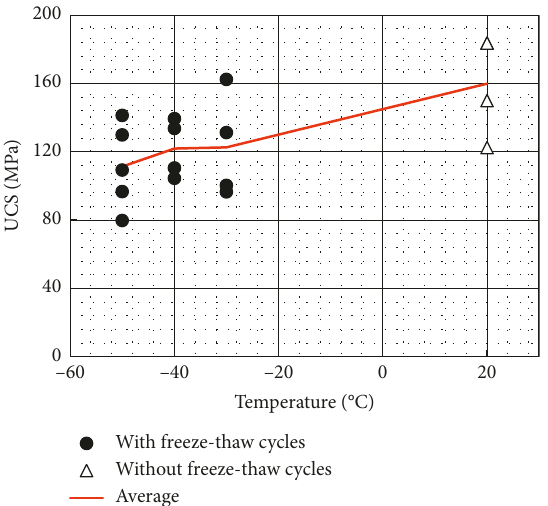
Figure 11: Young’s modulus of granite with and without exposure to freeze-thaw